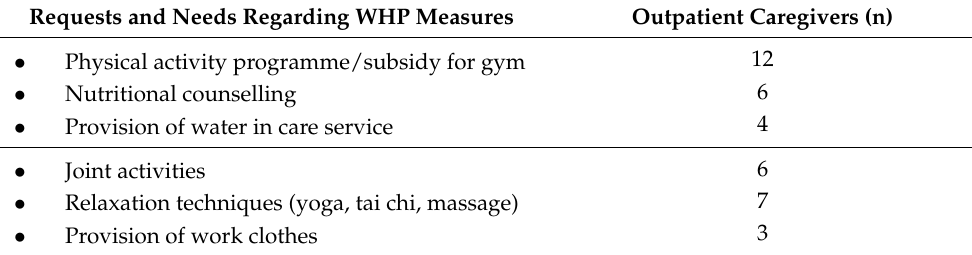
Table 4. Requests and needs of interviewed outpatient caregivers regarding further WHP